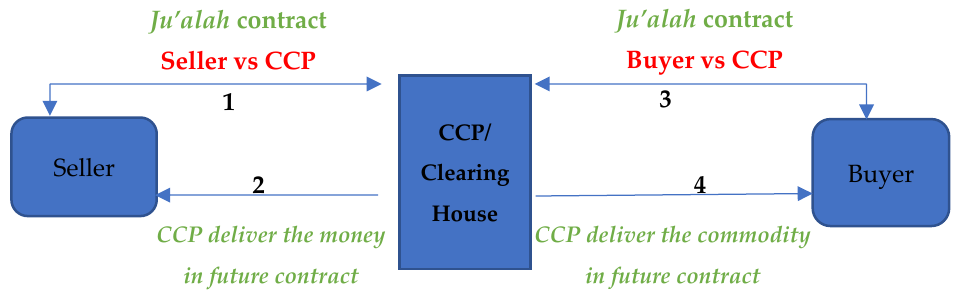
Figure 4. Ju’alah based future contract illustration in the OTC market.